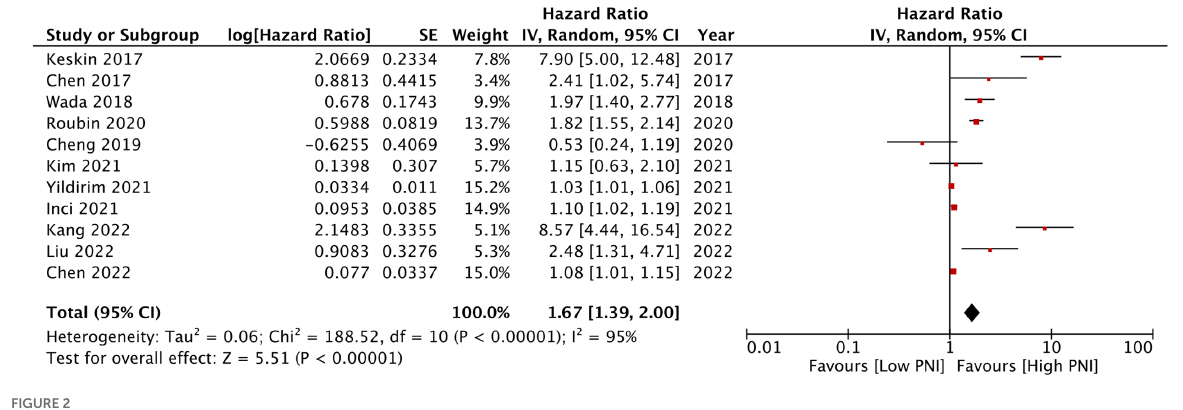
FIGURE 2 Meta-analysis of mortality with PNI as a categorical variable.